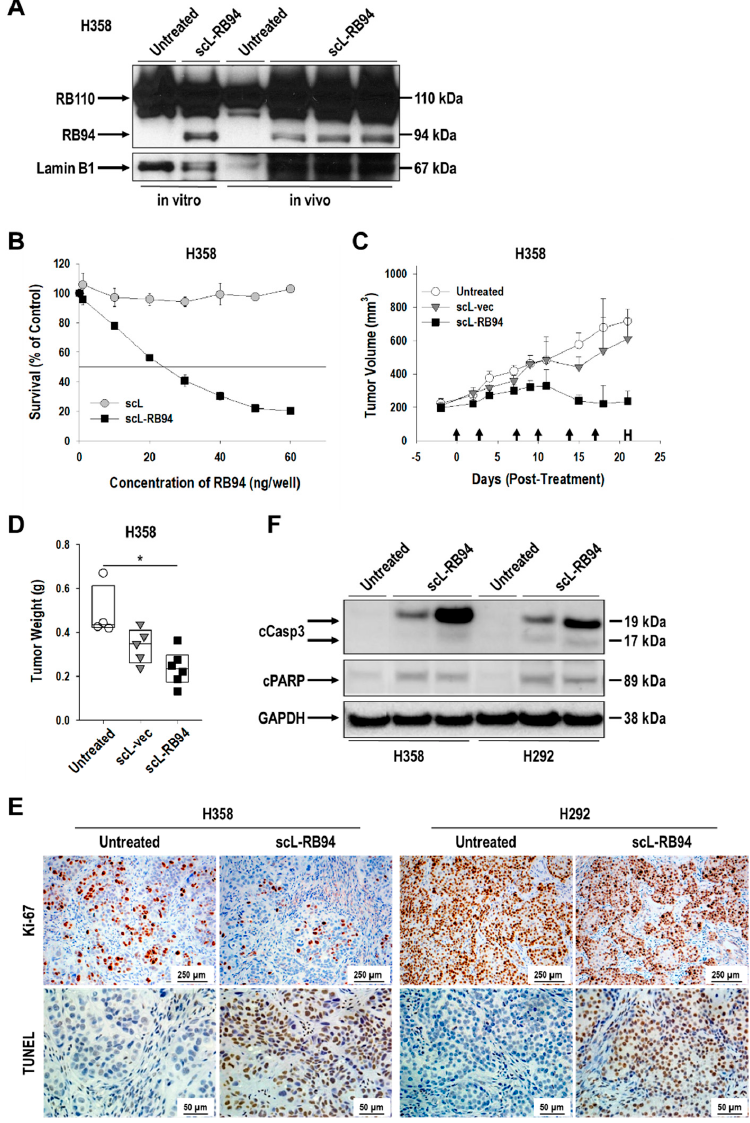
Figure 1. Expression of exogenous RB94 via scL-RB94 nanocomplex inhibits the proliferation and survival of human NSCLCs. ( A ) Western blot analysis depicting the expression of exogenous RB94 protein (94 kDa) in H358 cells both in vitro and in vivo after treatment with scL-RB94 nanocomplex. The expression of endogenous RB protein (110 kDa) is also shown. Expression of lamin B1 protein was utilized as an internal control for protein loading. ( B ) Cell viability in H358 cells was measured by XTT assay 72 h after transfection with increasing concentrations of scL-RB94 or empty nanocomplex without payload (scL). For in vivo study, athymic mice bearing subcutaneous H358 tumor xenograft were treated with either scL-vec or scL-RB94 (30 μ g/injection/mouse), as indicated by arrows in ( C ). ( C ) Tumor growth was monitored by measuring tumor volumes ( N = 5–8). ( D ) Tumors were harvested and weighed on day 21 (indicated by H). * p < 0.05, one-way ANOVA. In another in vivo study, athymic mice bearing either H358 or H292 tumors were treated with scL-RB94 (30 μ g/injection/mouse, two injections over 3 days). Forty-eight hours later, harvested tumors were processed for IHC and Western blot analyses ( N = 8). ( E ) Representative staining for the proliferation marker Ki-67 (upper panels) and the apoptosis marker TUNEL (lower panels). ( F ) Western blot analysis assessing changes in cleaved caspase-3 (cCasp3) and cleaved PARP (cPARP) protein levels. Expression of GAPDH protein was utilized as an internal control for protein loading. Original complete Western blot images for Figure 1 are provided in Figures S1 and